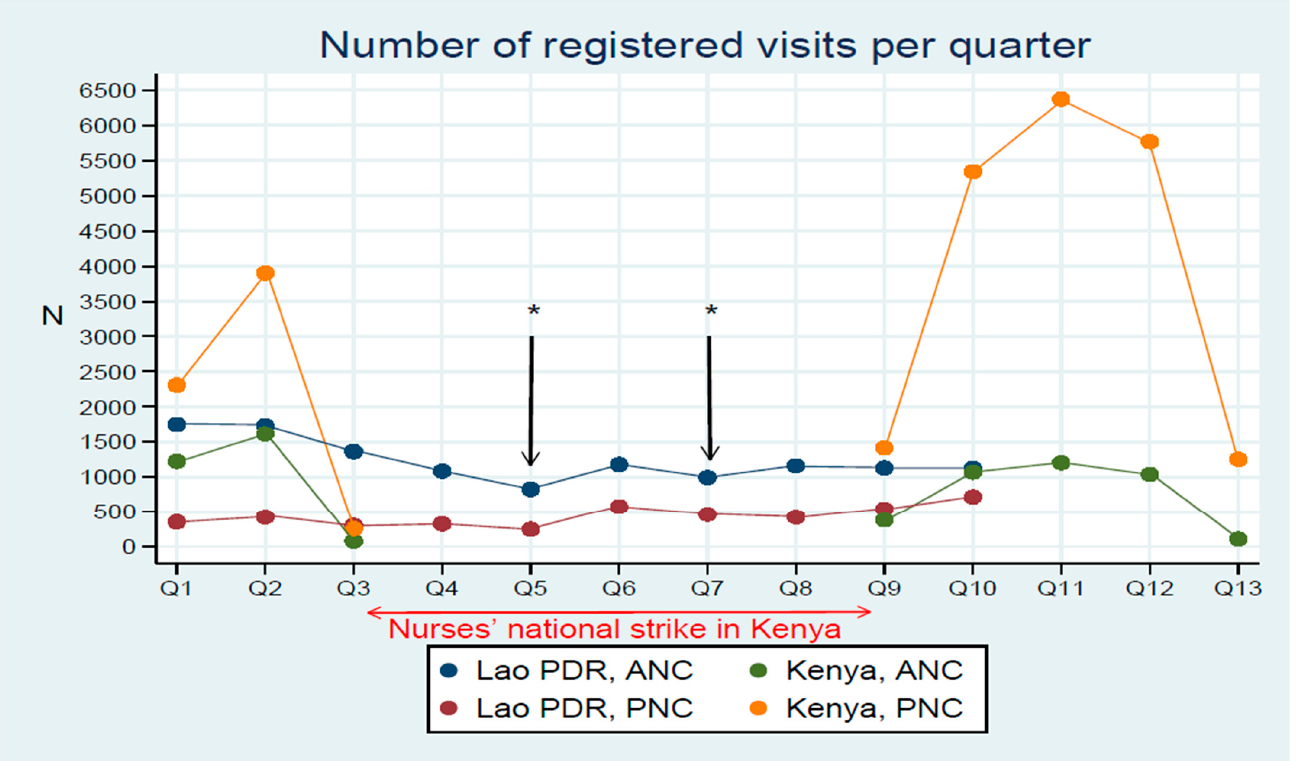
Figure 2. Numbers of registration at antenatal care (ANC) visits and postnatal care (PNC) visits per quarter in two study areas. In Lao PDR, there were delayed financial incentives in Q5 and Q7 (*). In Kenya, there was no registration process during Q4–Q8 because of the national nurses’ strike. Quarters in Kenya: from April 2017 (Q1) until April 2020 (Q13); those in Lao PDR: from August 2017 (Q1) until January 2020 (Q10).